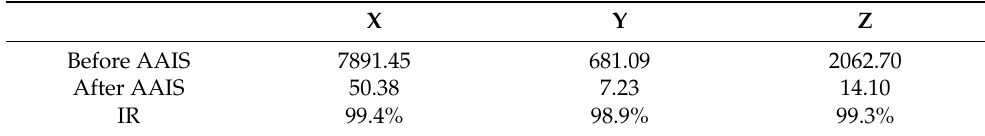
Table 6. The standard deviation (nT) in the dynamic